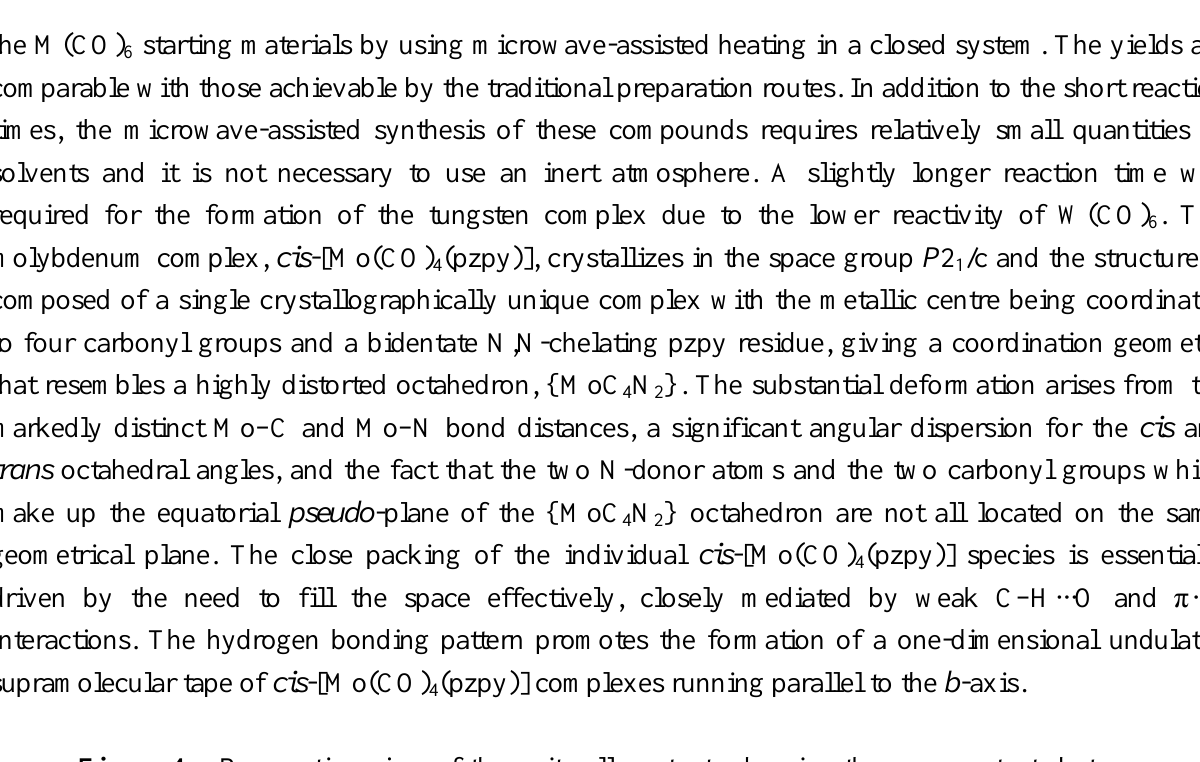
Perspective view of the unit cell contents showing the π ··· π contacts between neighbouring aromatic rings of coordinated ethyl[3-(2-pyridyl)-1- pyrazolyl]acetate residues belonging to adjacent hydrogen-bonded supramolecular